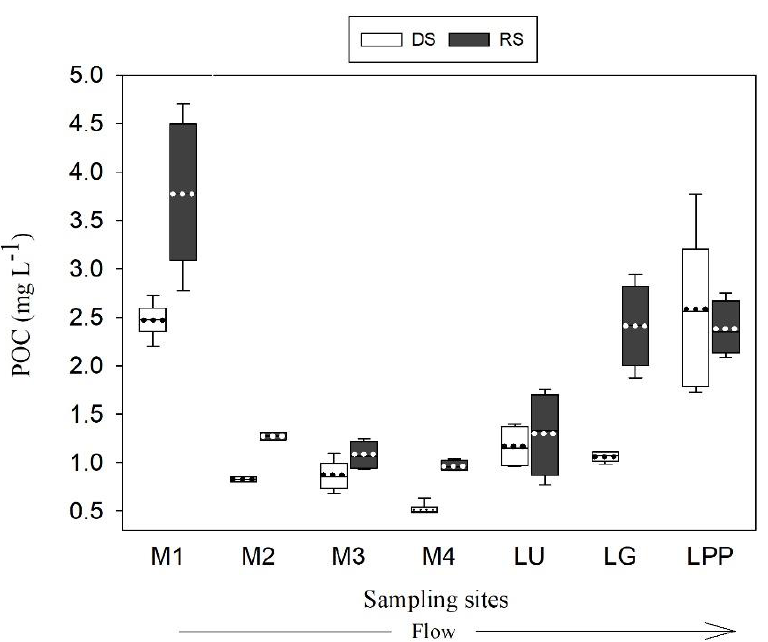
Figure 6. Box and whisker plot showing the seasonal and spatial distribution of the POC concentration in the Usumacinta River basin. Boxplots represent the 25th and 75th percentiles of the concentration, and the dotted line within each box represents the mean. The whiskers represent the standard deviation.